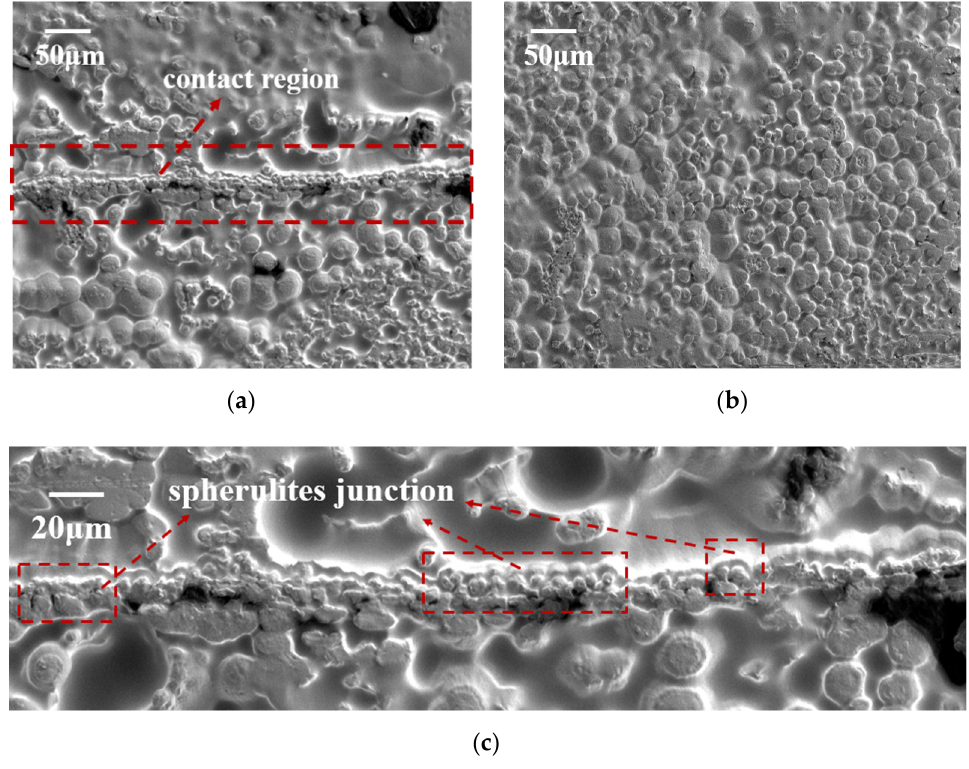
Figure 5. The spherulite surface morphology: ( a ) H-XLPE bilayer; ( b ) XLPE; ( c ) enlarged image of contact region of H-XLPE bilayer.